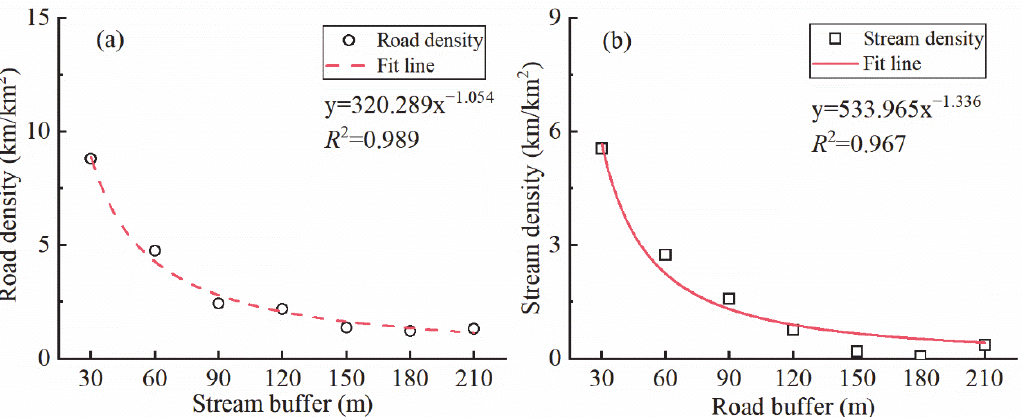
Figure 5. Density of forest roads ( a ) and streams ( b ) within various buffer zone distances of streams and forest roads, respectively.